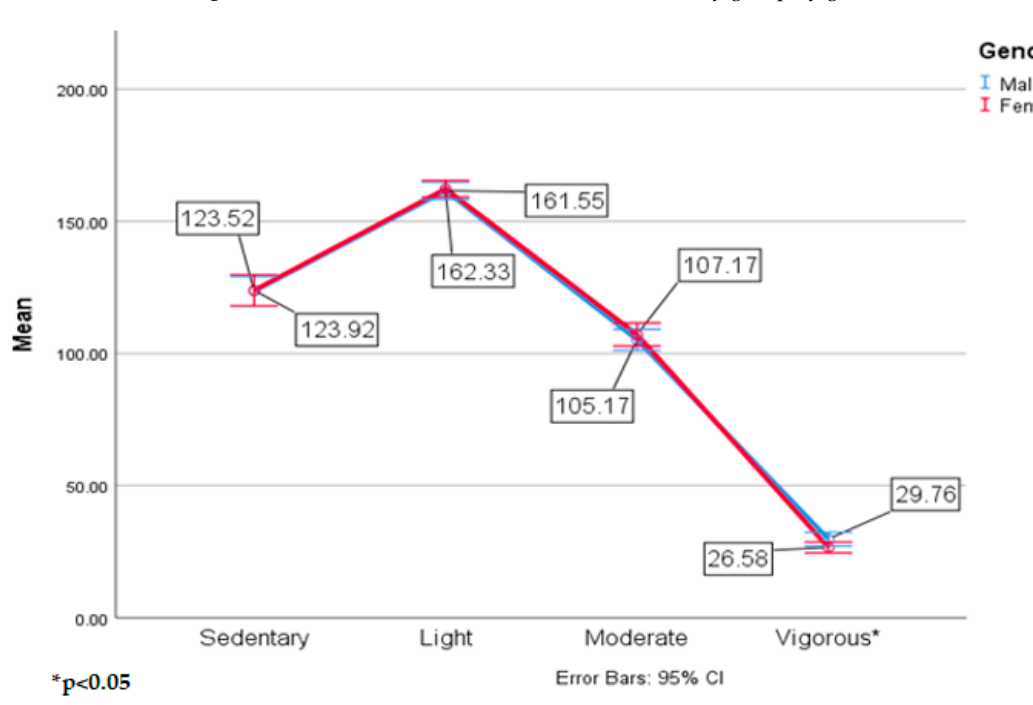
Figure 5. Means and standard deviations of MVPA by group by grade .